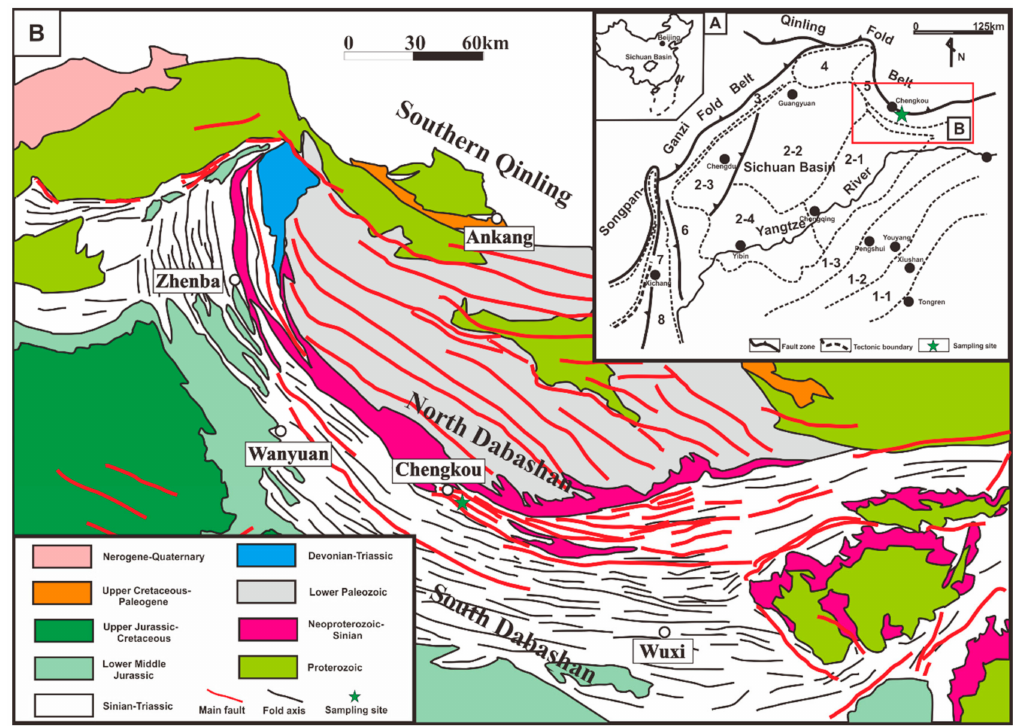
Figure 1. Simplified geological maps and location of the Sichuan Basin ( a ) and Dabashan ( b ) (Modified from Li et al. [6], Ma et al. [7], Kang et al. [10]). 1-1: Xuefengshan fold subzone; 1-2: Western Hubei-Eastern Chongqing-Northern Guizhou fold subzone; 1-3: Qiyueshan-Jinfoushan-Daloushan fold subzone; 2-1: Eastern Sichuan fold belt; 2-2: Central Sichuan fold belt; 2-3: Western Sichuan fold belt; 2-4: Southern Sichuan fold belt; 3: Longmenshan fold belt; 4: Michangshan fold belt; 5: Dabashan fold belt; 6: Emeishan-Daliangshan block-fault belt; 7: Xichang basin; 8: Kangdian tectonic